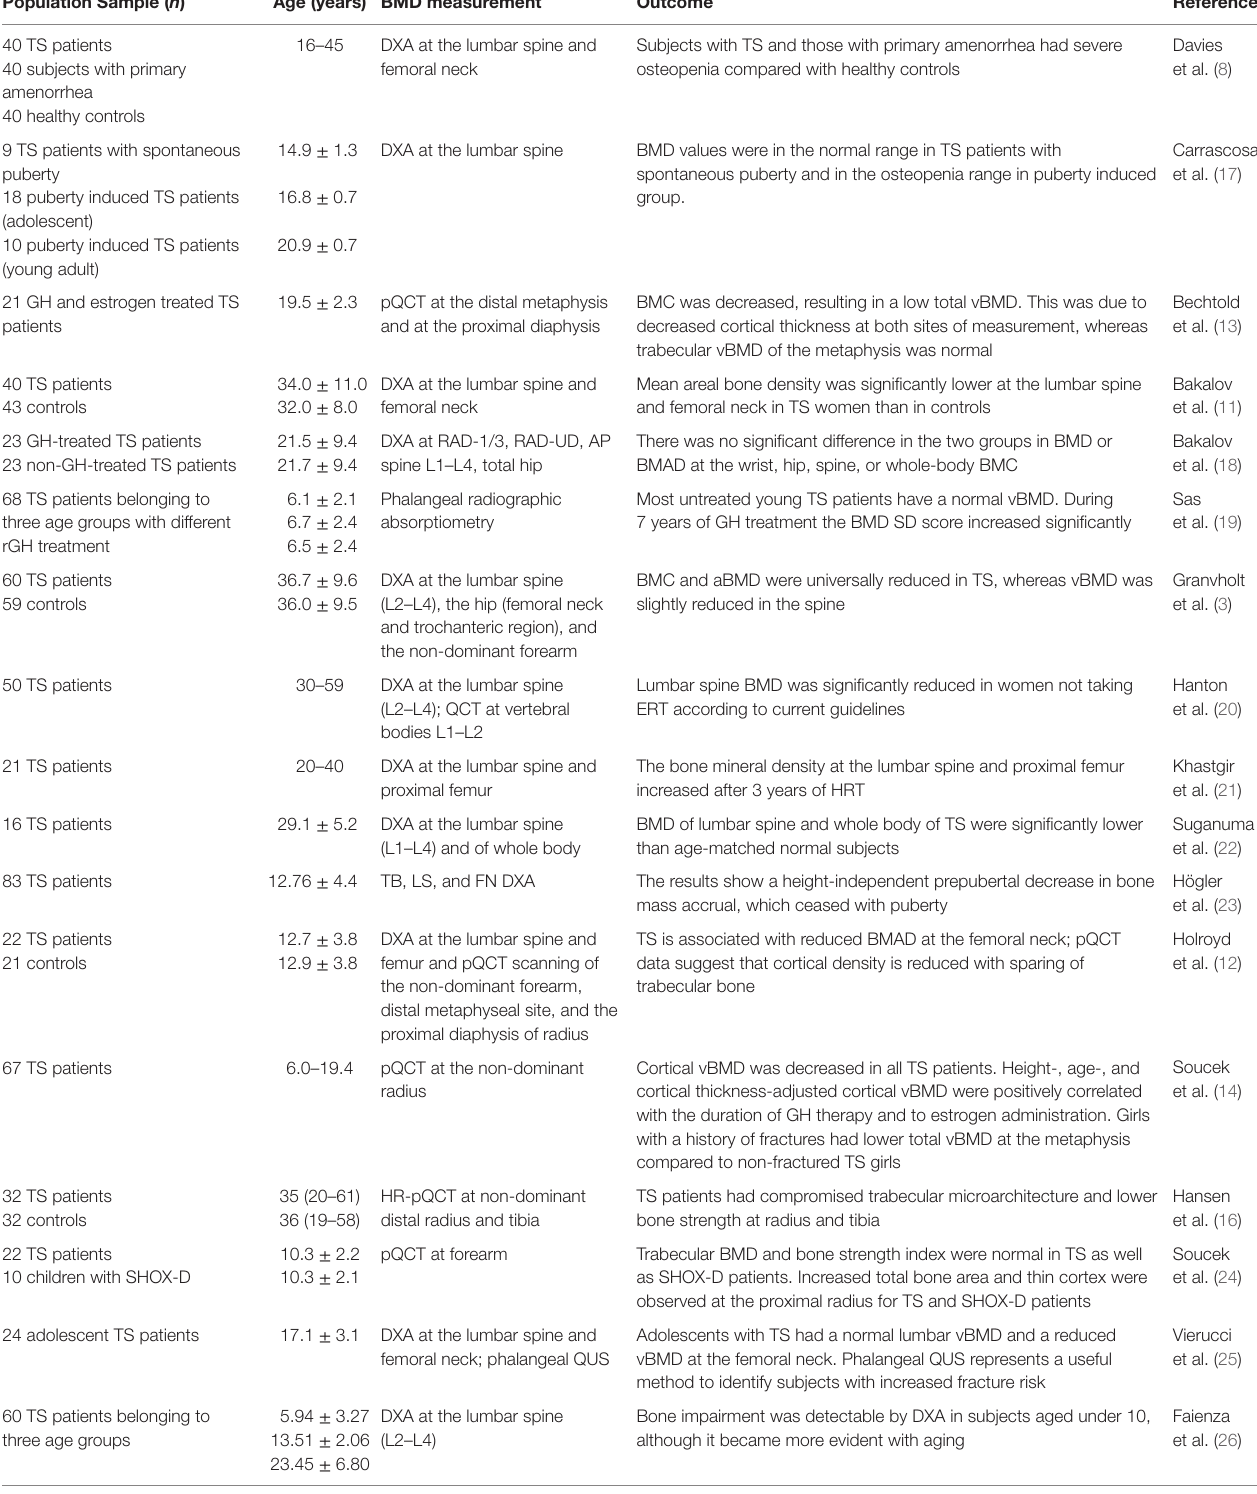
TABLe 1 | BMD measurements in TS